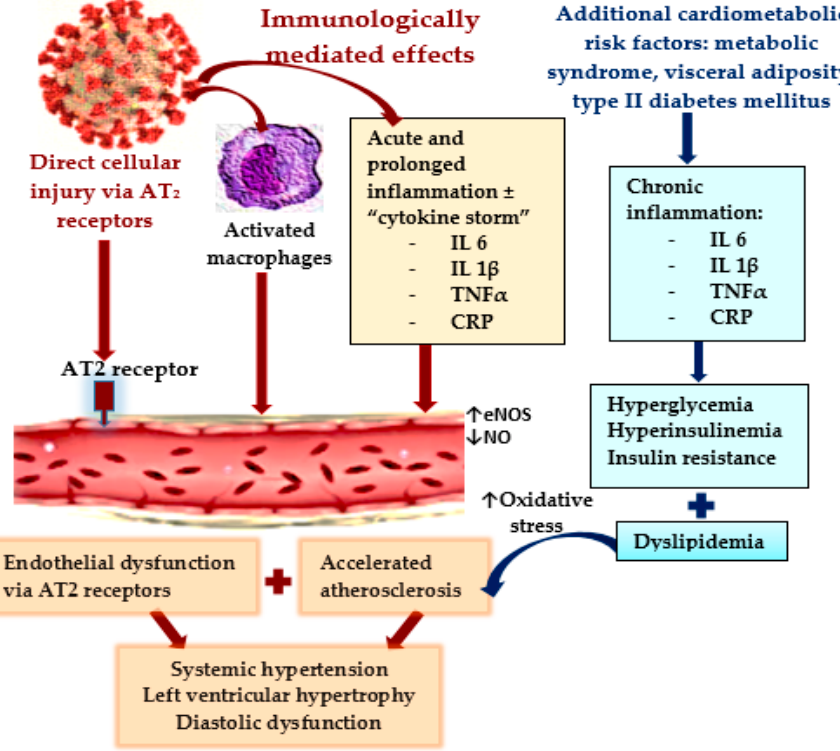
Figure 1. Pathophysiological mechanisms responsible for endothelial dysfunctions and their conse- quences in